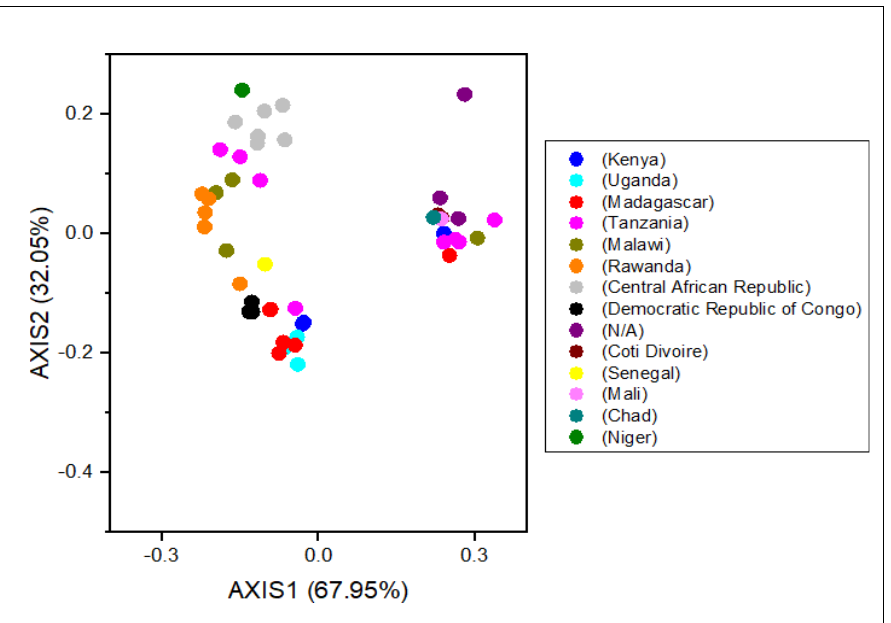
Figure 5. A correspondence analysis (COA) of the genes in RYMV genomes. Each point represents a gene corresponding to the coordinates of the first and second axes of variation generated from the correspondence analysis.